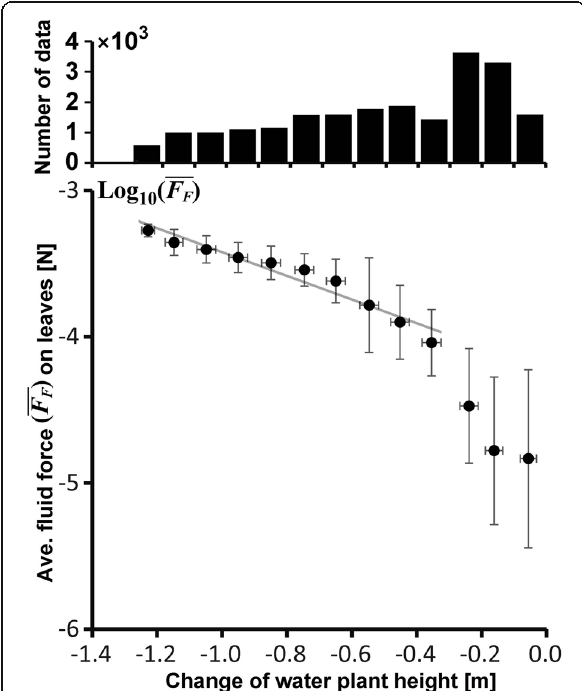
Fig. 17 The relationship between the time-averaged fluid force (Fig. 15) and height changes of the submerged macrophytes (Fig. 6). The upper panel shows the number of sample data counted in all grids of the southern basin with a bin of 0.1 m for the height changes of the submerged macrophytes. The lower panel shows the plots of the averaged values for the fluid forces and height changes (black dots) with the standard deviation (bars) using the sample